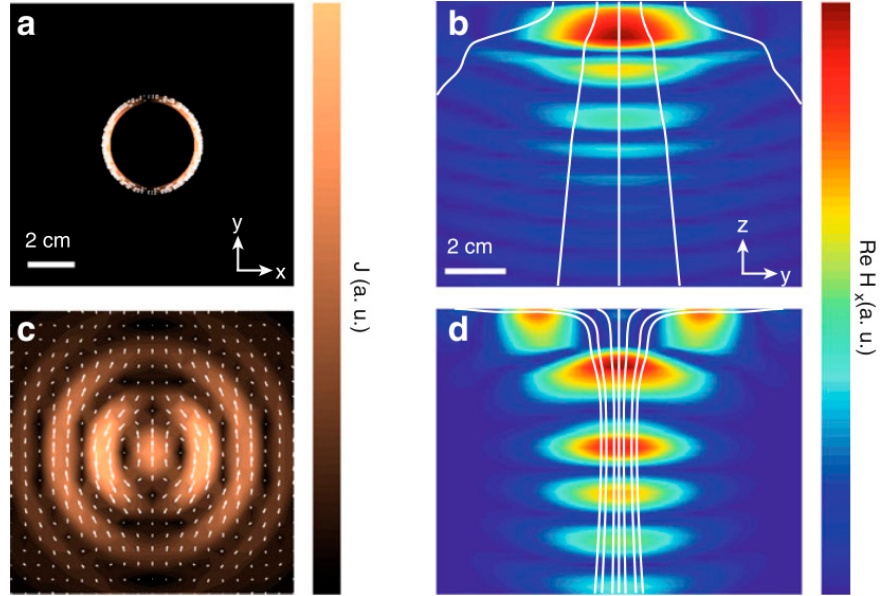
Figure 30. Current density and magnetic field distribution for a coil source ( a , b ) and optimal source ( c , d ) at 2.6 GHz [48,154]. The magnetic field component aligned with the receiver dipole moment and the Poynting vector (white lines) generated by the coil source and the optimal source. Copyright © 2013, IEEE.